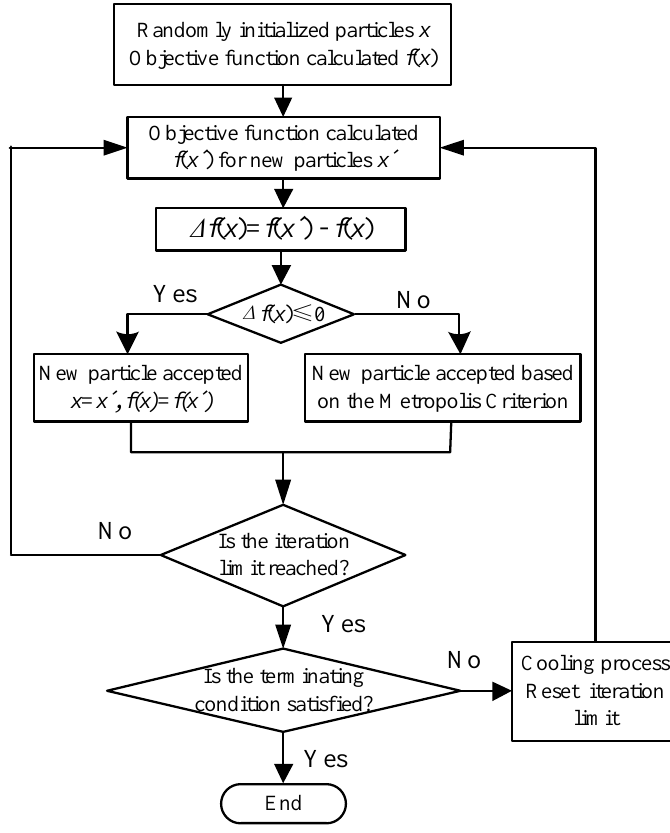
Figure 4. Optimization model based on the simulated annealing particle swarm optimization algorithm.